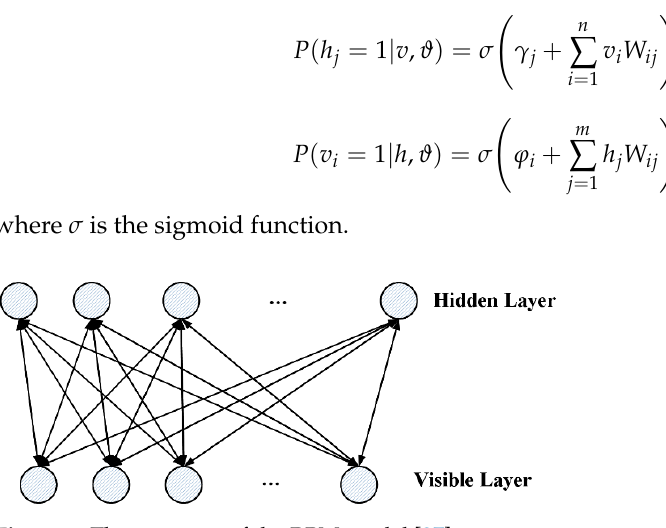
Figure 9. The structure of the RBM model [37].